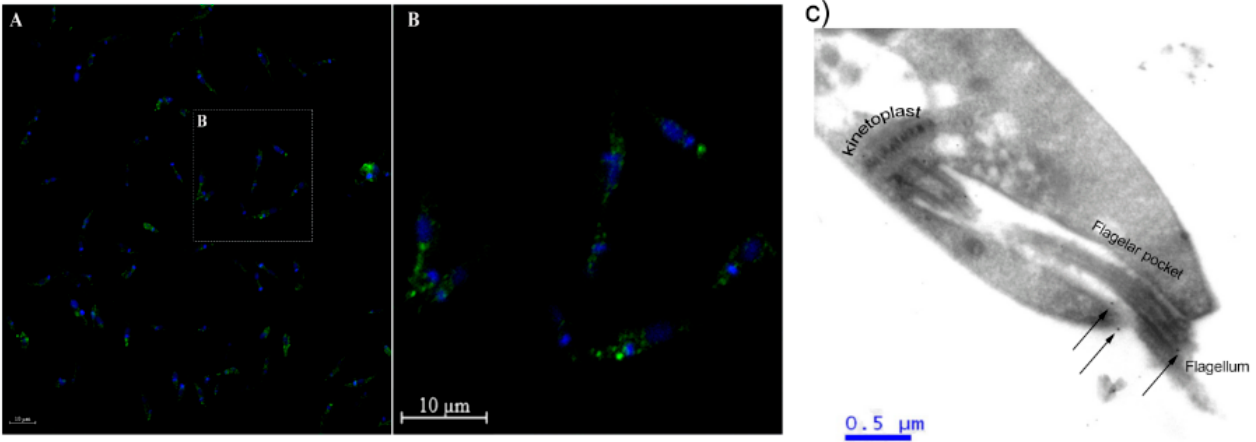
Figure 2. Immunolocalization of L. amazonensis subtilisin. ( A ) Paraformaldehyde-fixed L. amazonensis promastigotes were permeabilized with Triton X-100 and labeled with anti-subtilisin antibody (1:400) and an Alexa 488 secondary antibody (1:750). The parasites were then analyzed by immunofluorescence microscopy. Parasites treated with the secondary antibody alone presented no fluorescence intensity (data not shown). The images shown are representative of three independent experiments. Statistical analysis by Student’s t -test p < 0.05. ( B ) The labeling of the cell cytoplasm, in detail. Bar represents 10 µ m ( C ) Transmission electron microscopy of L. amazonensis promastigotes using anti-subtilisin (1:200) and gold-conjugated anti-IgG antibodies (arrows). Scale 0.5 µ